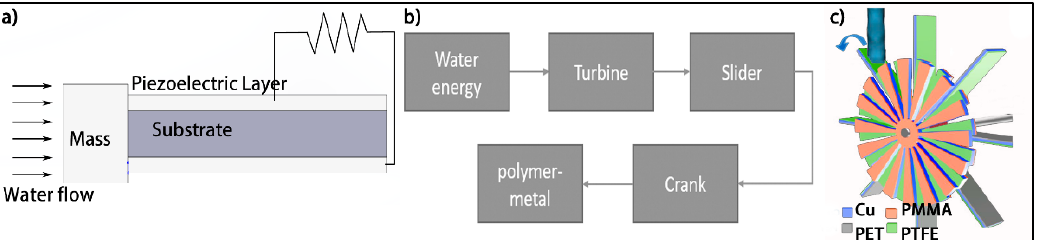
Figure 7. Underwater small energy harvester in various energy harvesting forms. ( a ) Flexible cantilever beam-mass structure piezoelectric harvester (reproduced with permission [74]. Copyright 2012, AIP). ( b ) Turbine-crank connected energy harvester. ( c ) Water TENGs and disk TENGs compound energy harvester (reproduced with permission [78]. Copyright 2014, ACS).